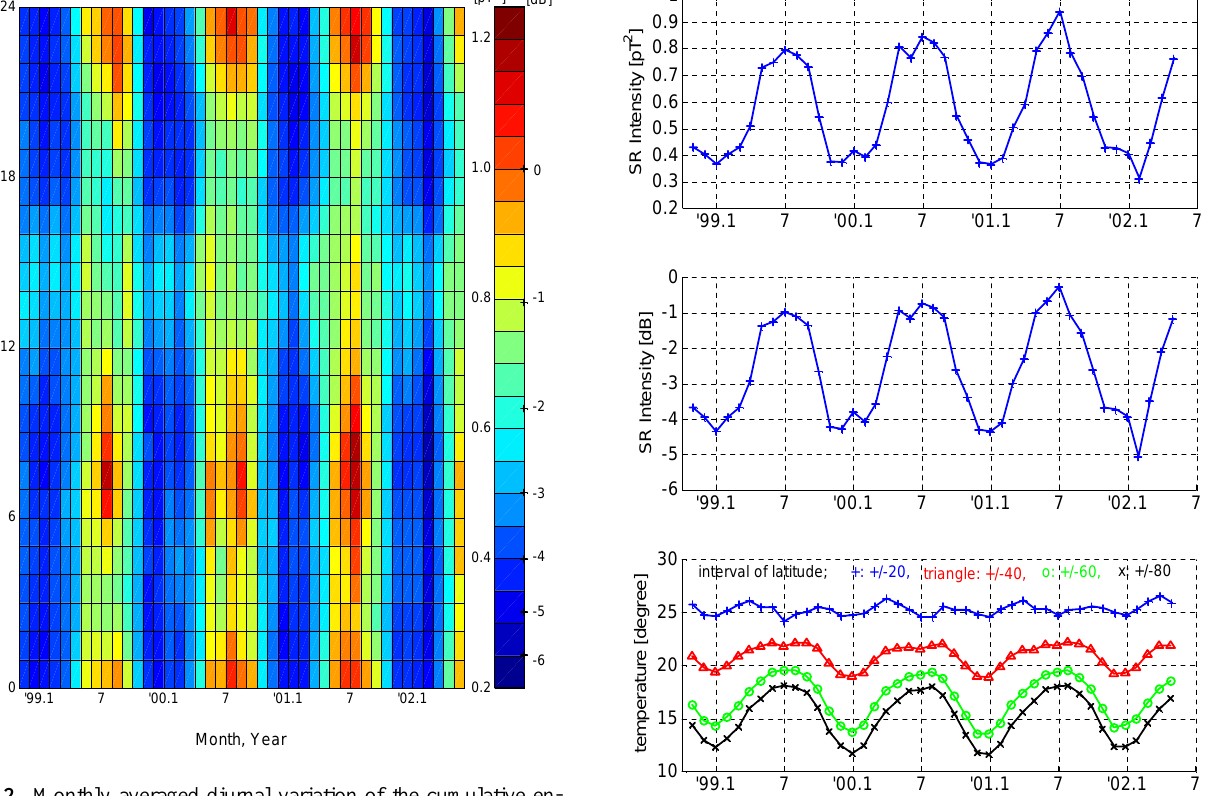
Fig. 3. Seasonal variations of electromagnetic and temperature data. Top and middle panels show the Schumann resonance in- tensity in pT 2 and in dB, correspondingly. Bottom panel presents the global mean ground temperature in symmetric latitudinal belts ± 20 ◦ , ± 40 ◦ , ± 60 ◦ , ± 80 ◦